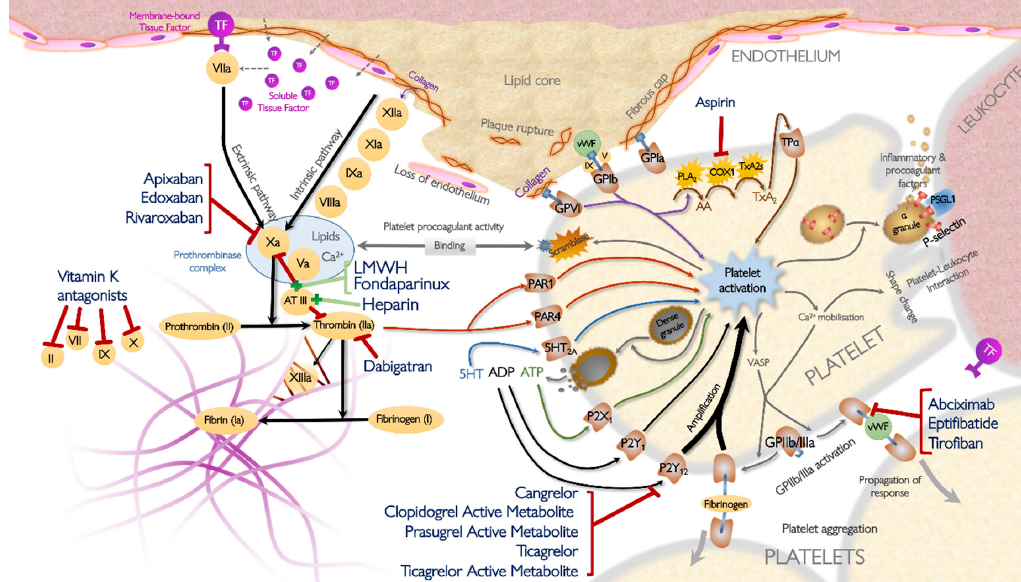
Figure 1. Mechanisms of action of established antithrombotic drugs in the context of the atherothrombotic response. Modified from Parker & Storey (Thrombotic Response, ESC Textbook of Cardiovascular Medicine 3rd edition, 2018, Oxford University Press). 5HT, 5-hydroxytryptamine (serotonin); AA, arachidonic acid; ADP, adenosine diphosphate; ATIII, antithrombin III; ATP, adenosine triphosphate; Ca 2 + , calcium; COX1, cyclo-oxygenase 1; GP, glycoprotein; IXa, activated factor IX; P2 × 1, platelet ATP receptor; LMWH, low- molecular weight heparin; P2Y 1 / P2Y 12 , platelet ADP receptors; PAR, protease activated receptor; PLA2, phospholipase A2; PSGL1, P-selectin glycoprotein ligand 1; TF, tissue factor; TP α , thromboxane receptor α ; TXA2, thromboxane A2; TXA2s, thromboxane A2 synthase; Va, activated factor V; VIIa, activated factor VII; VIIIa, activated factor VIII; VASP, vasodilator-stimulated phosphoprotein; vWF, von Willebrand factor; Xa, activated factor X; XIa, activated factor XI; XIIa, activated factor XII; XIIIa, activated factor